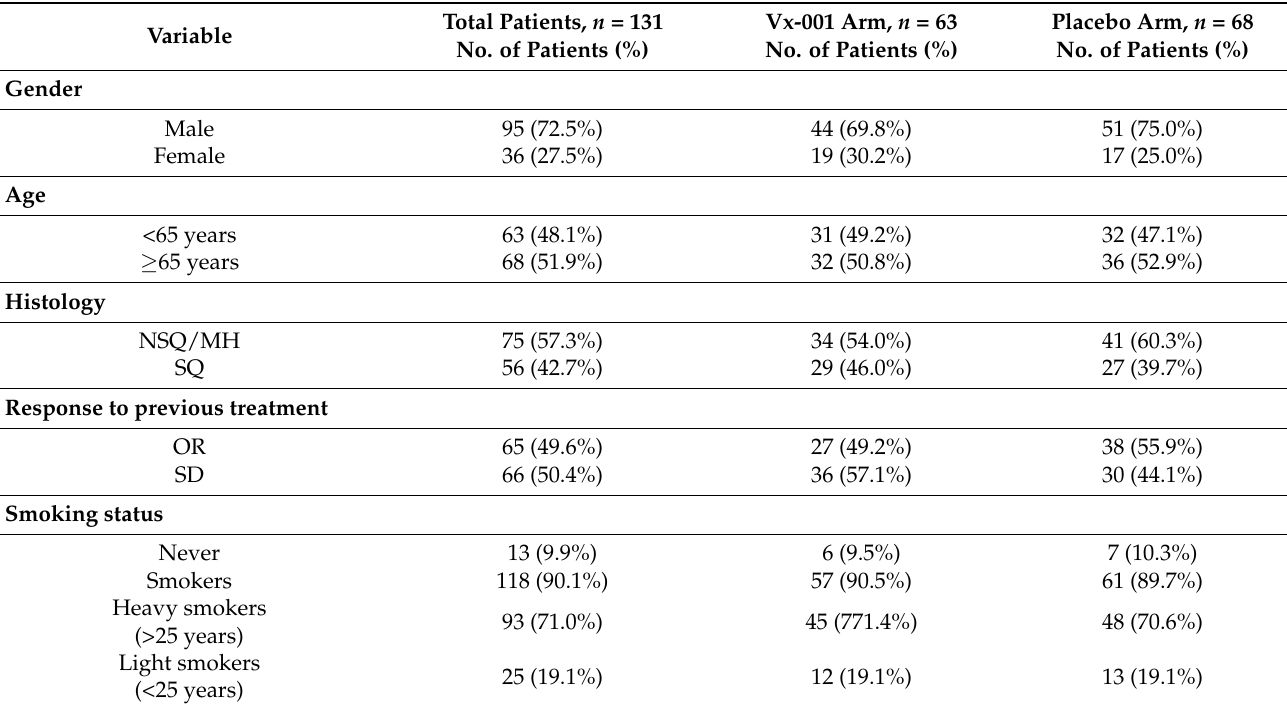
Table 1. Patients’ characteristics.